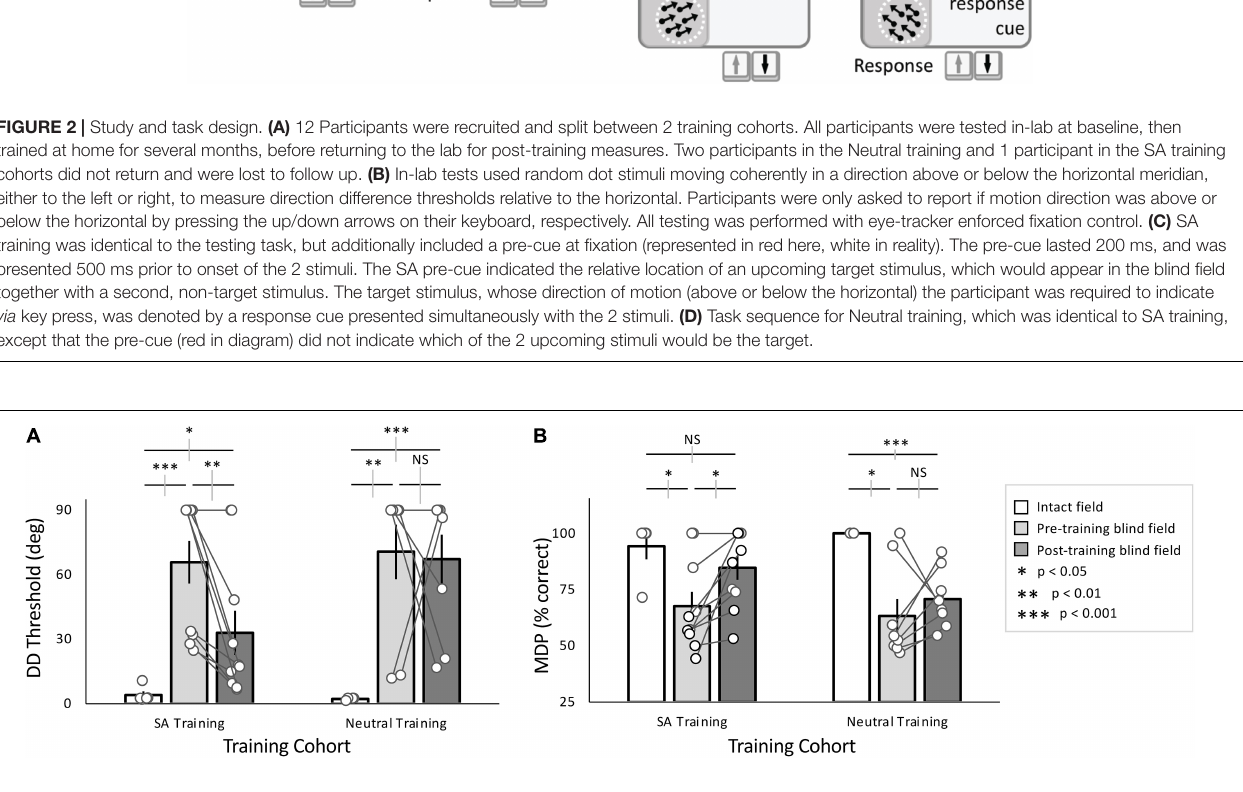
FIGURE 3 | Effects of training with SA- and Neutral pre-cues. (A) Plot of mean ( ± SEM) direction difference (DD) threshold, with individual data superimposed (white circles). Intact field performance was largely normal across both cohorts (white bars), while baseline (pre-training) performance in the blind field was similarly impaired for both cohorts (light gray bars). After training (dark gray bars), the majority of SA-trained participants, and the group as a whole improved over baseline. However, the group average remained impaired relative to the intact field. In contrast, the majority of Neutral-trained participants did not attain lower thresholds after training. As a group, they did not improve from baseline and remained impaired relative to their intact field. (B) Plot of mean ( ± SEM) percent correct performance at the minimum difficulty (MDP), in this case a 90 ◦ DD from horizontal. Intact field performance for both cohorts was similarly good (white bars), and baseline performance in the blind field was impaired (light gray bars) relative to their intact visual fields. All participants in the SA training cohort improved relative to their own pre-training levels, attaining post-training MDP % correct performance that was not significantly different from their intact field. In comparison, the Neutral-trained cohort did not improve significantly from baseline overall, and remained impaired relative to their own intact fields. Gray error bars on comparisons lines indicate ± 1 standard error of the difference between the compared means; see text for descriptive statistics.